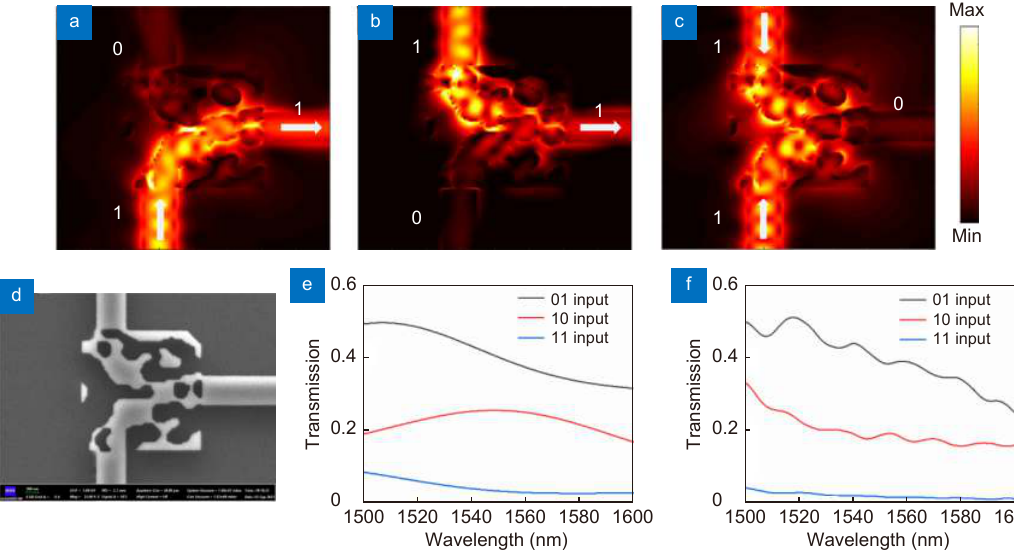
Fig. 5 | Characterization of the all-optical XOR logic gate. ( a ) The “01” input of normalized intensity distribution in the x - y plane from theoretic- al calculation. ( b ) The “10” input of normalized intensity distribution in the x - y plane from theoretical calculation. ( c ) The “11” input of normalized intensity distribution in the x - y plane from theoretical calculation. ( d ) Scanning electron microscopy (SEM)image of the XOR logic gate. The size of the optimized area was 2 μm×2 μm. ( e ) Simulation results of the transmission of all-optical switch. ( f ) Experiment results of the normalized transmission of all-optical XOR logic